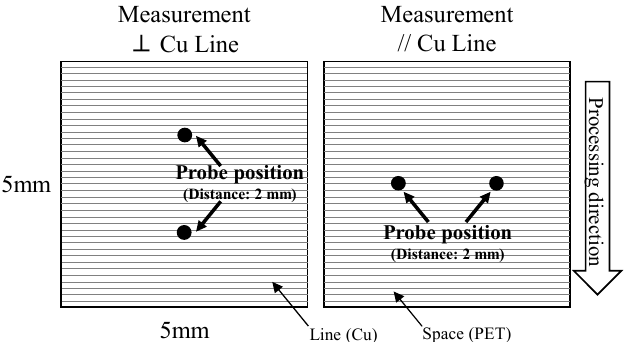
Figure 2. Measurement of electrical resistance and evaluation of anisotropic electrical conduction for SS-processed Cu/PET films.